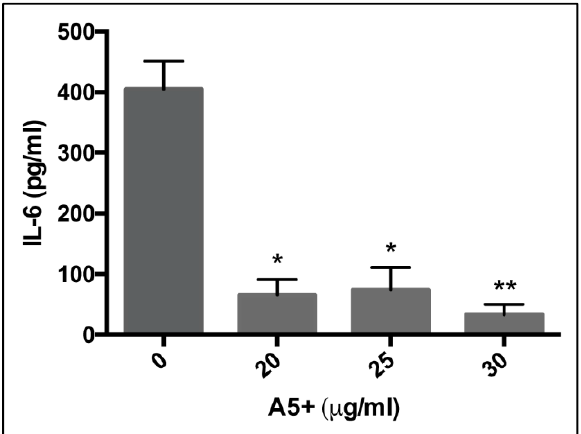
Figure 3. A5+ compound reduces IL-6 production in influenza virus-infected cells. IL-6 production (pg/mL) in supernatants of Vero E6 cells infected with influenza virus A/PR/8/H1N1 and treated with A5+ compound at different concentrations (20–30 µg/mL) for 24 h. DMSO-treated infected cells were used as control (0). Cytokine production was quantified by using ELISA assay as described in Materials and Methods. Results are the mean ± S.D. obtained from two independent experiments, each performed in duplicate (* p < 0.05 and ** p < 0.001 vs. infected DMSO-treated cells).